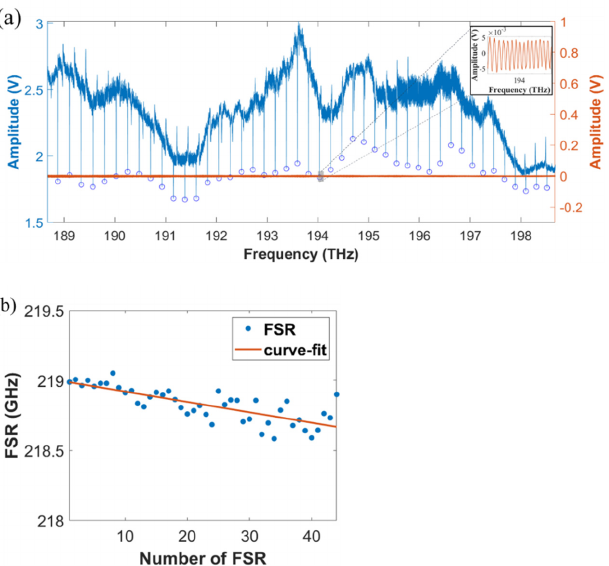
Figure 9. ( a ) Transmission spectrum of the microresonator (blue line) with cladded layer stripping. The corresponding interference fringes from the interferometer system (orange line). The zoom-in spectrum of the interference fringes is shown in the inset. ( b ) Distribution of FSRs.